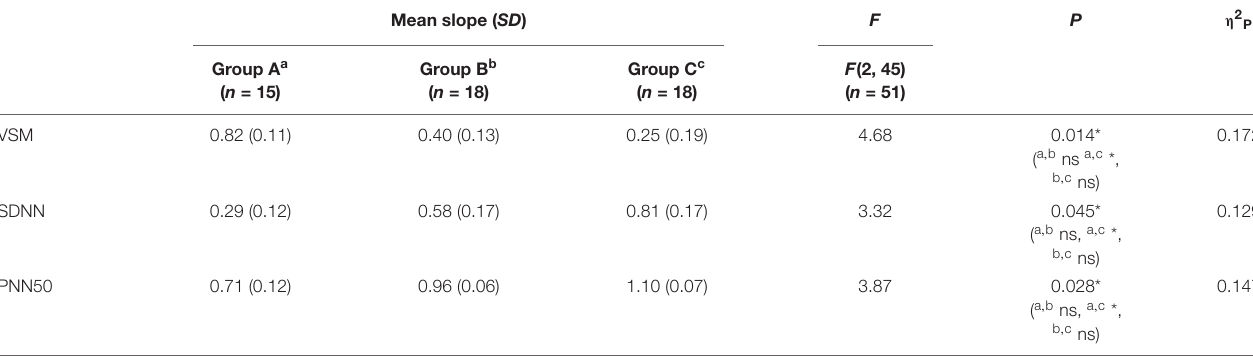
FIGURE 5 | Symbols and lines plot for analysis of covariance with significant results of electrooculogram and photoplethysmogram features. (A) Vertical saccadic movement (VSM). (B) Standard deviation of normal to normal (N-N) intervals (SDNN). (C) The % of the total N-N intervals in which the difference between two consecutive N-N intervals is geater than 50ms (PNN50). * p < 0.05 ( post-hoc of analysis of covariance with Bonferroni correction). TABLE 2 | Mean and standard deviation ( SD ) of slope, F , and p -value of analysis of covariance (ANCOVA) on electrooculogram and photoplethysmogram